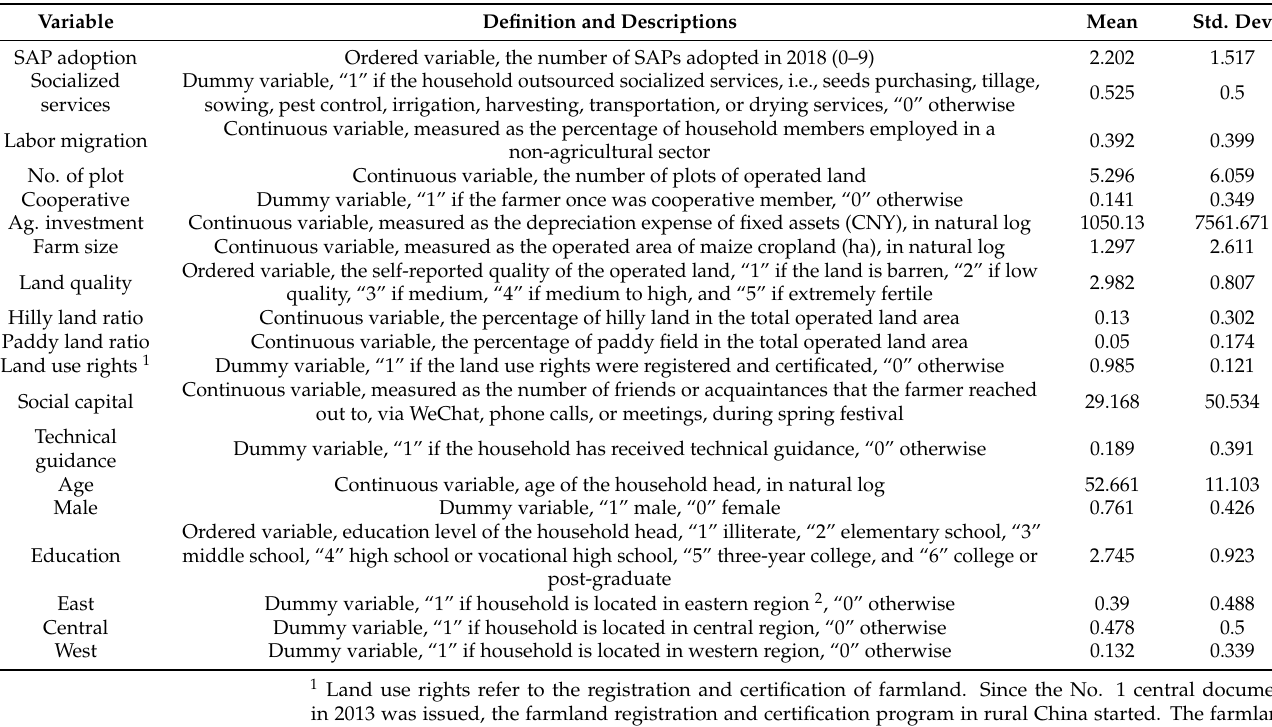
Table 1. Variable and definition.